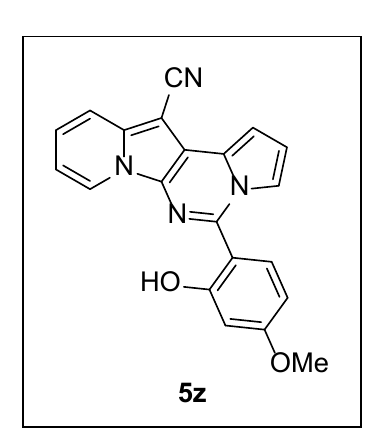
123.1, 119.2, 119.0, 117.7, 116.0, 115.3, 113.2, 112.4, 111.9, 102.1, 72.7, 56.0; HRMS (ESI- QTOF) m / z [M+H] + calcd for C 21 H 15 N 4 O 2 355.1190, found 355.1201.